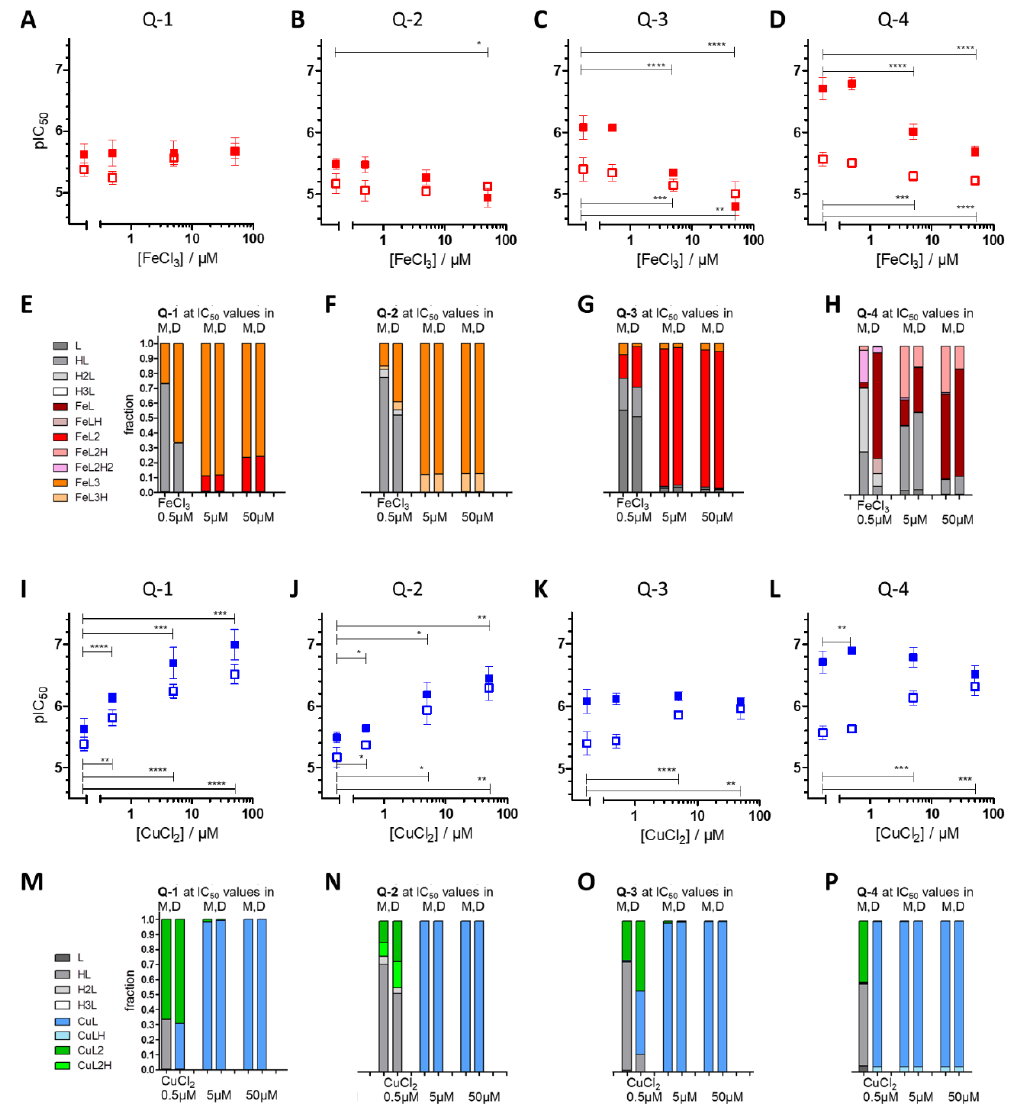
Figure 2. Effect of increasing concentrations of FeCl 3 (red, A – D ) or CuCl 2 (blue, I – L ) on the toxicity of the compounds Q-1 ( A , I ), Q-2 ( B , J ), Q-3 ( C , K ) and Q-4 ( D , L ). pIC 50 values of the compounds were obtained by the MTT assay following 72 h incubation of MES-SA (open squares) and MES-SA/Dx5 (filled squares) cells in the absence or presence of constant metal ion concentrations. Data represent mean values and standard deviations obtained in at least three independent experiments (*: p ≤ 0.05, **: p ≤ 0.01, ***: p ≤ 0.001, ****: p ≤ 0.0001). Molar fractions of the complexes formed with ligands Q-1 to Q-4 at pH 7.4 at the IC 50 values of the compounds in MES-SA (M) and MES-SA/Dx5 (D) cell lines upon co-incubation with 0.5, 5, or 50 µM FeCl 3 ( E – H ) and CuCl 2 ( M – P ) were calculated on the basis of experimentally determined stability constants from Reference [60] for Q-1 ( E , M ), Q-2 ( F , N ), Q-3 ( G , O ) and Q-4 ( H , P ). The color code of the single species is given on the left side, and charges are omitted for clarity.